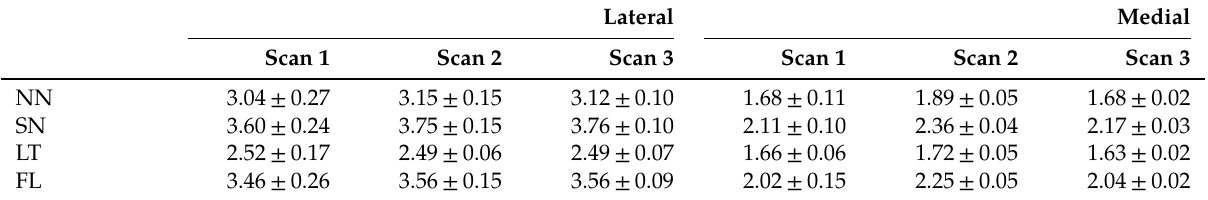
Table 4: Mean thickness values (mm) of the methods on noisy data with standard